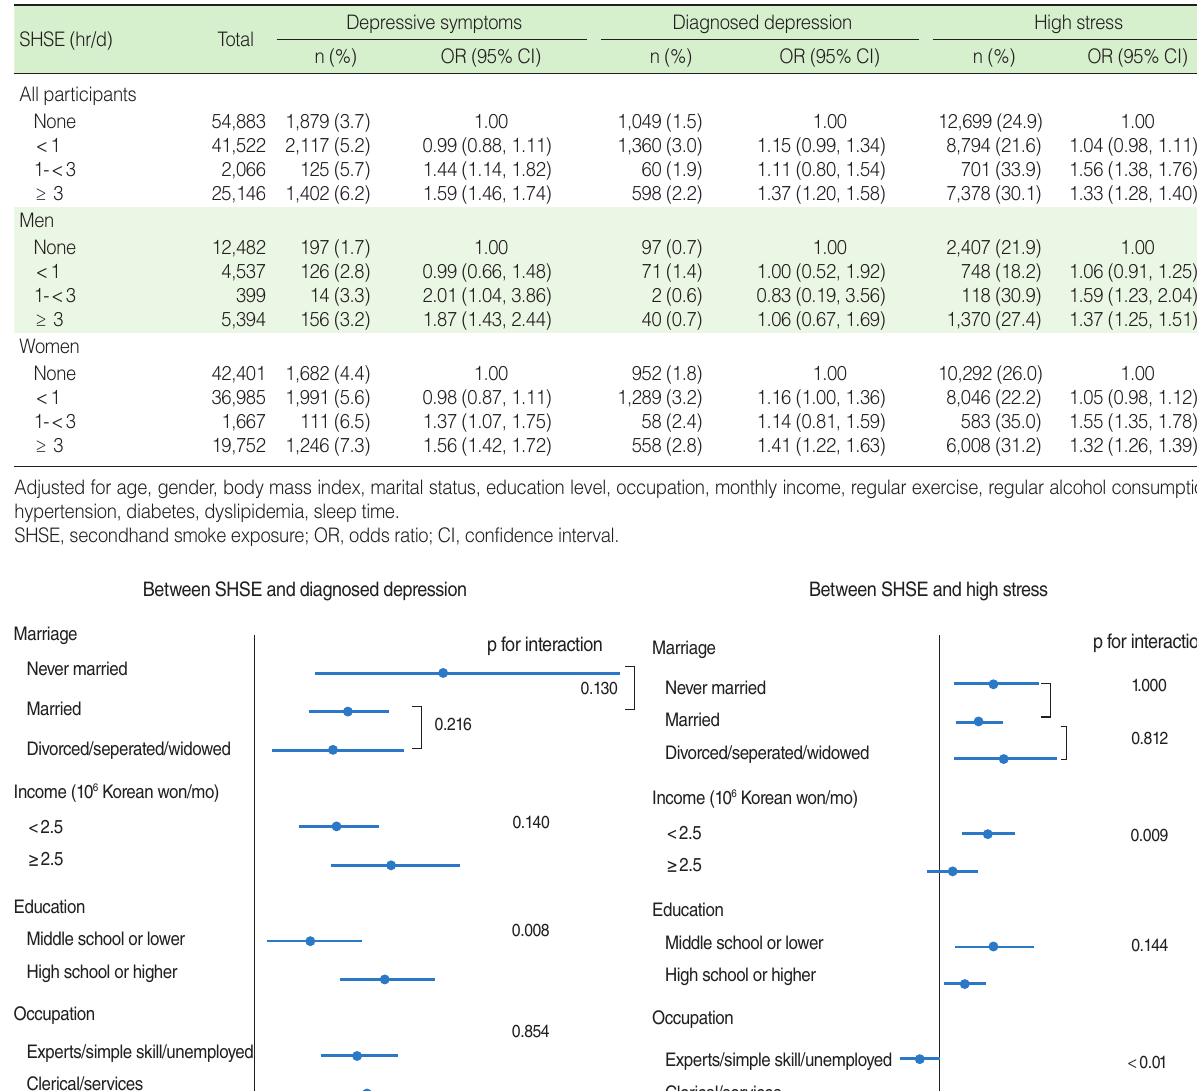
Table 3. Association between SHSE and mental health problems in all participants